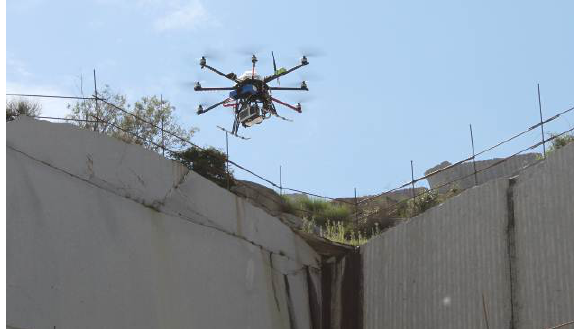
Figure 2. UAV platform: oktokopter.